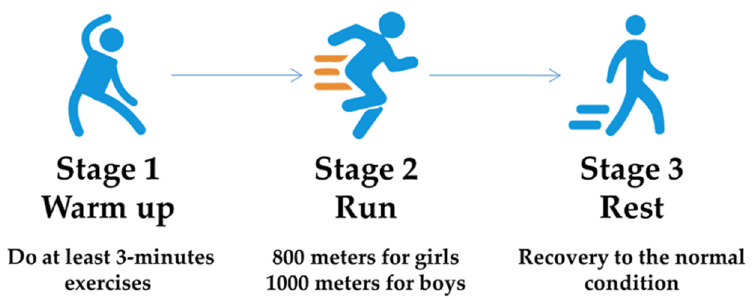
Figure 3. Flowchart of the experimental paradigm.